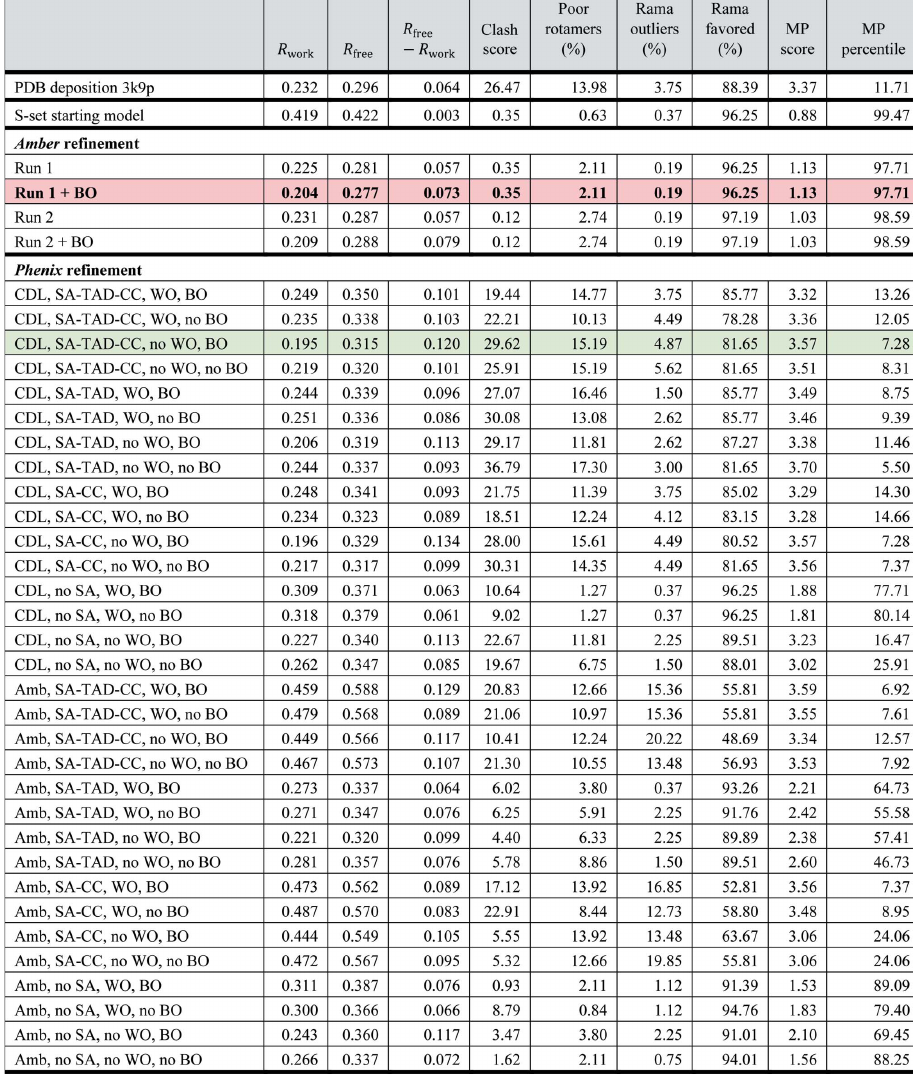
Figure 4 Structural statistics of the crystallographic structure with PDB code 3k9p, the derivative scrambled model, four models from the Amber -based refinement procedure and 32 models from the Phenix -based refinement procedure. Abbreviations: Rama, Ramachandran; MP, MolProbity ; CDL, conformation-dependent library; Amb, Amber ff14SB; SA, simulated annealing; TAD, torsional angle dynamics; CC, Cartesian coordinates; WO, weight optimization; BO, B -factor optimization (see Section 2.5 for further details). The best ( i.e. lowest R free ) Amber -refined model is indicated by pink shading and the best Phenix -refined model by green